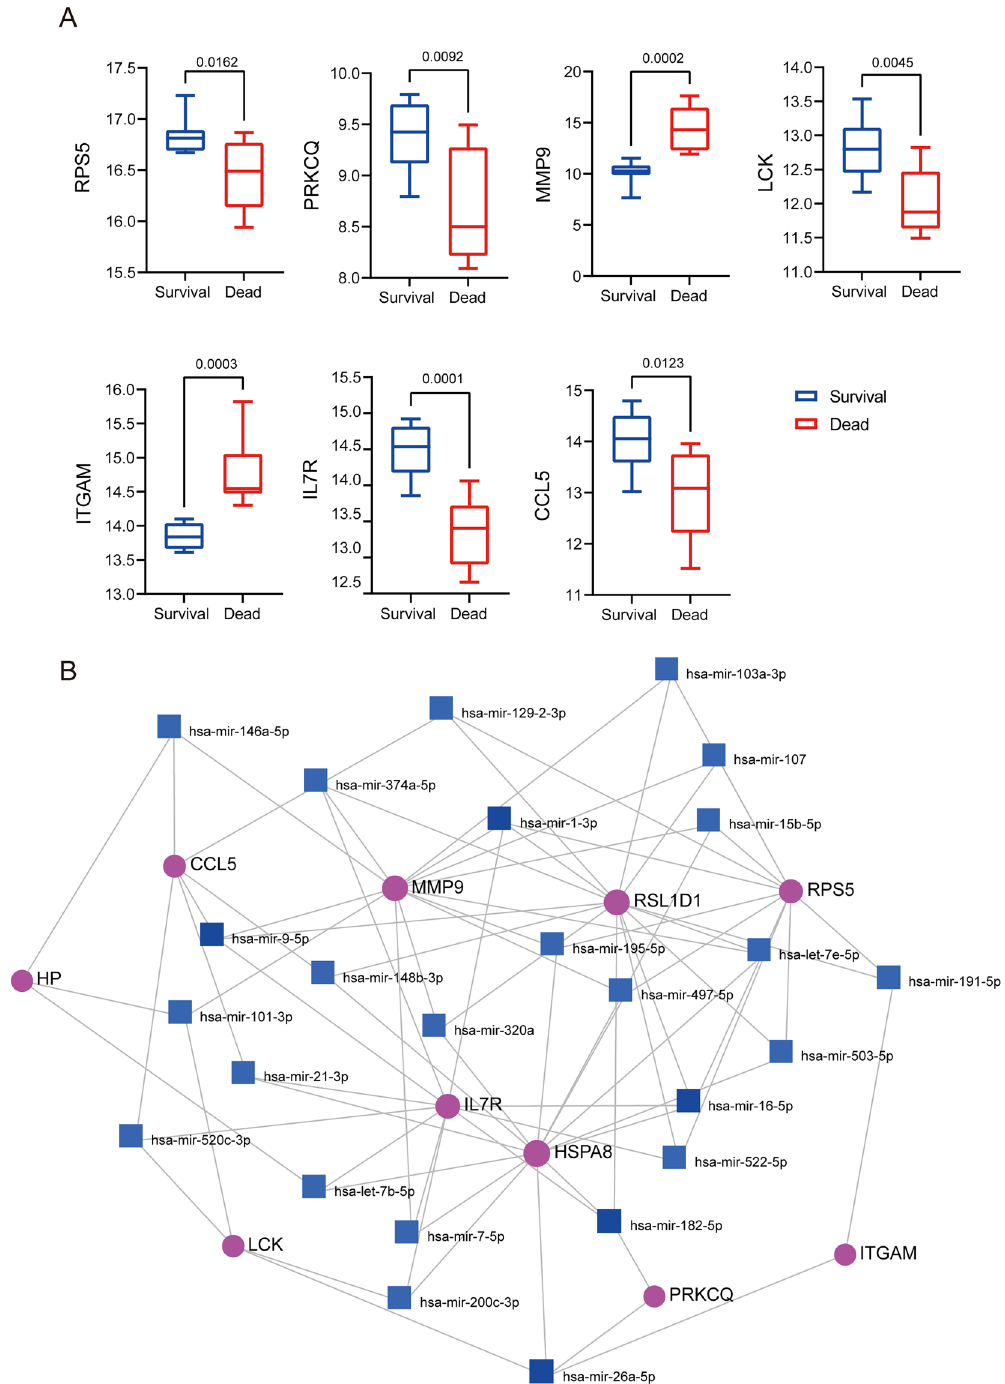
Figure 12. Validation of hub genes and prediction of miRNAs. ( A ) The expression of seven of these hub genes was statistically different in the GSE168048 samples. ( B ) miRNA–hub genes regulatory network. Purple circles represent hub genes, while blue squares represent